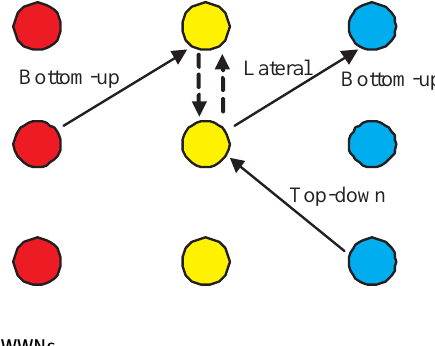
Figure 2: Three Connection Modes in